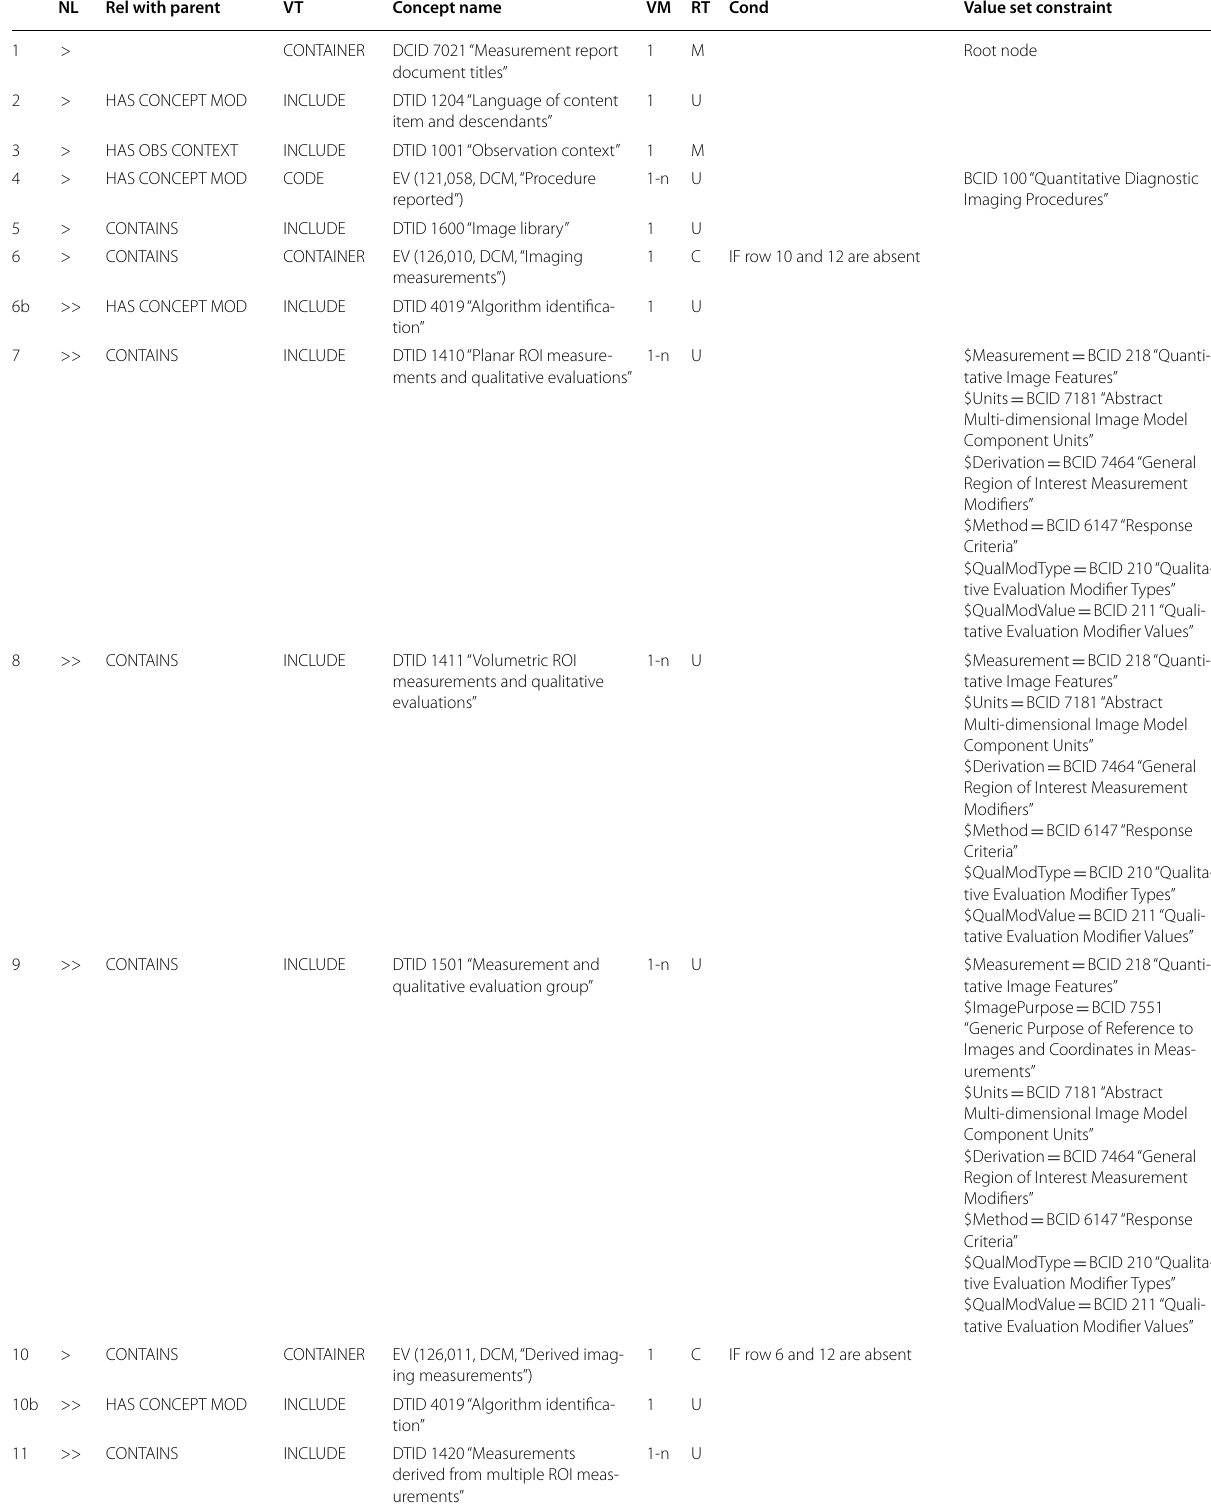
Table 3 DICOM SR template for measurement report, template ID 1500 (from DICOM